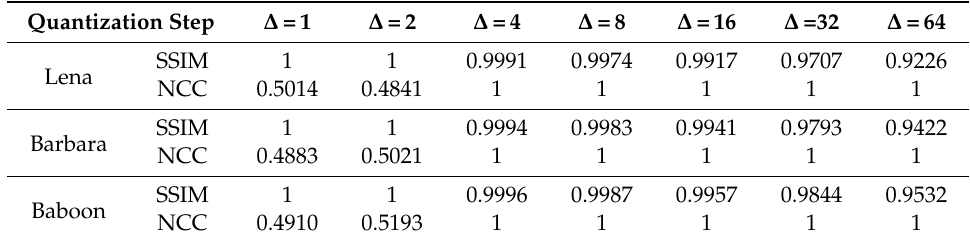
Table 1. Structural similarity (SSIM) index and normalized correlation coefficient (NCC) values of the proposed scheme under different quantization